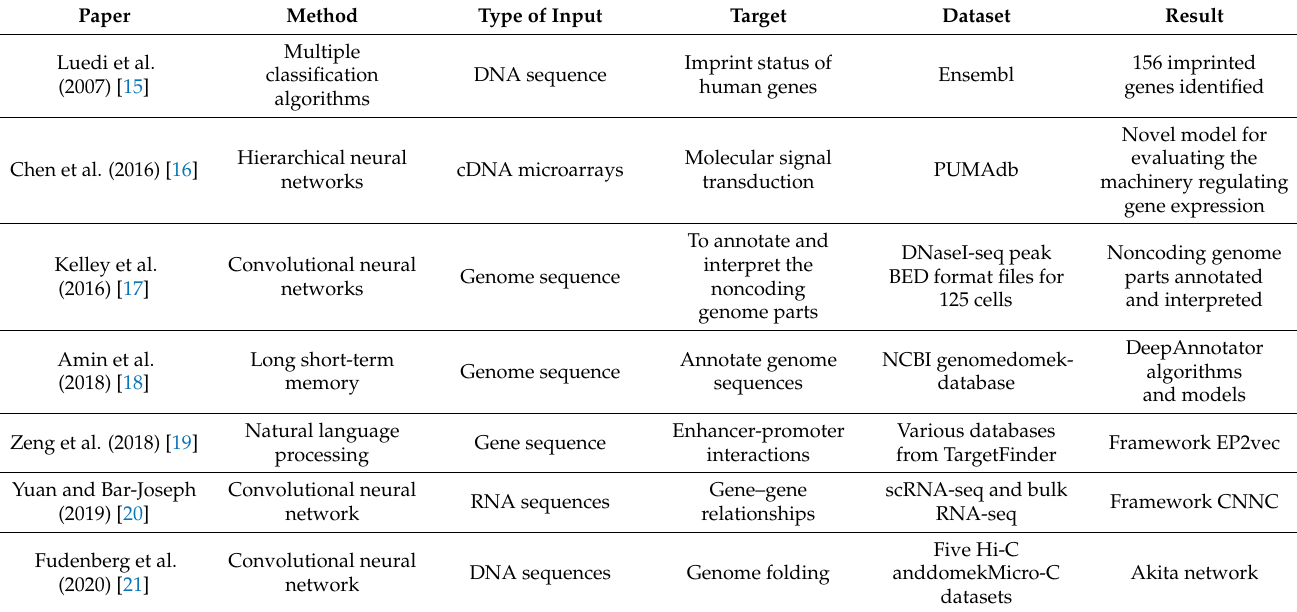
Table 1. Summary of the existing machine-learning approaches for DNA sequence